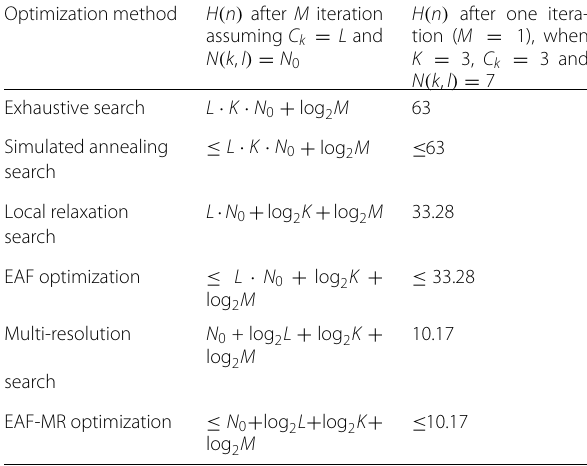
Table 3 H ( n ) in (21) of optimization methods Optimization method